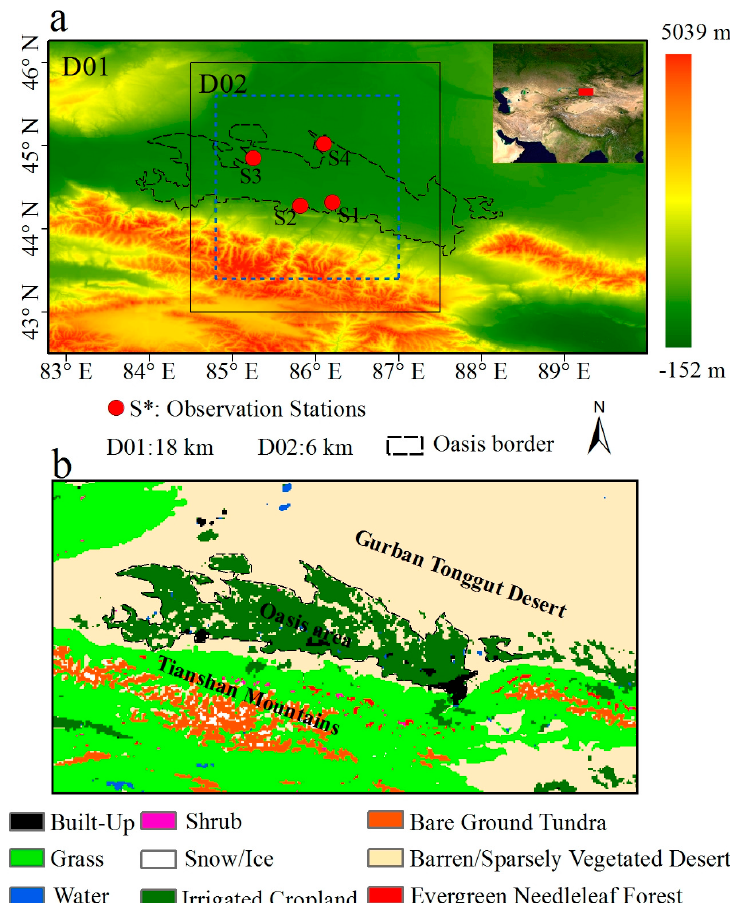
Figure 1. Topography ( a ) and land cover ( b ) of the study area in 2012 and the Weather Research and Forecasting (WRF) simulation domains (blue dotted line in ( a ) shows the horizontal extent of the analyzed area in the subsequent figures).